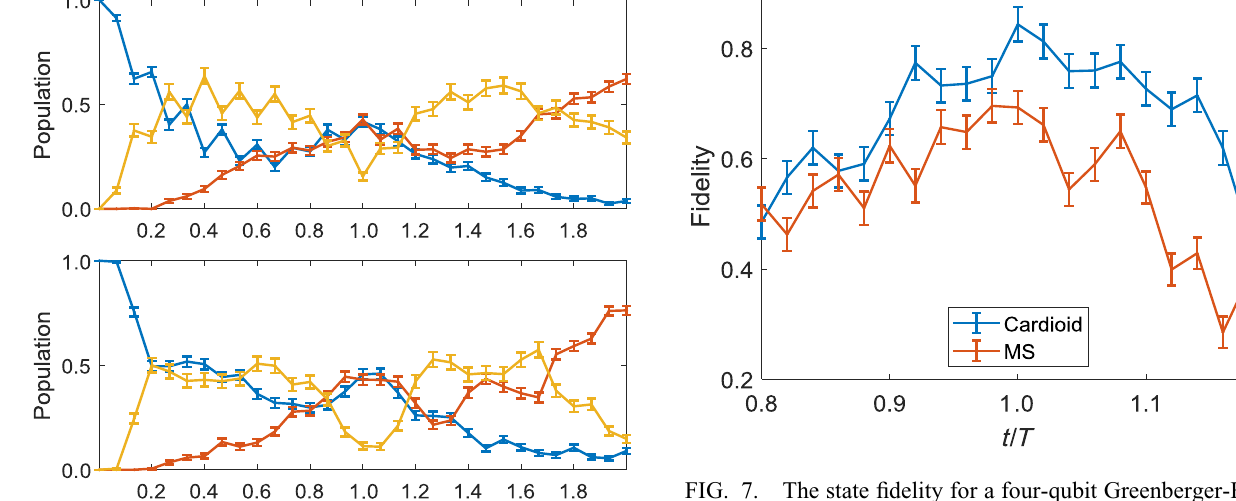
FIG. 7. The state fidelity for a four-qubit Greenberger-Horne- Zeilinger (GHZ) state generated by the cardioid (blue) and MS (red) gates is measured for different gate times. The cardioid gate exhibits a higher peak fidelity and reduced sensitivity to pulse- time errors compared to